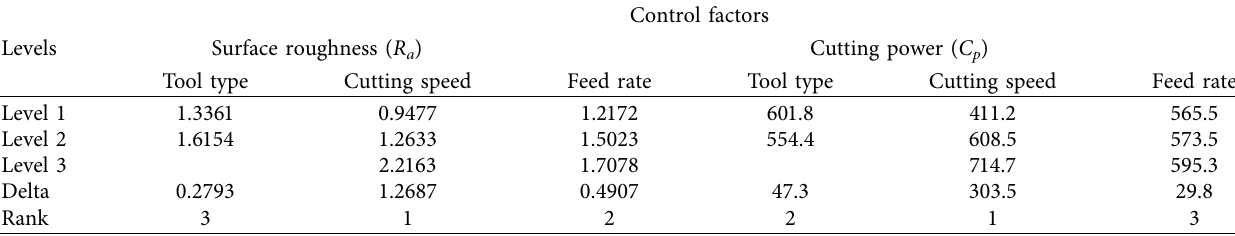
a and C p factors.